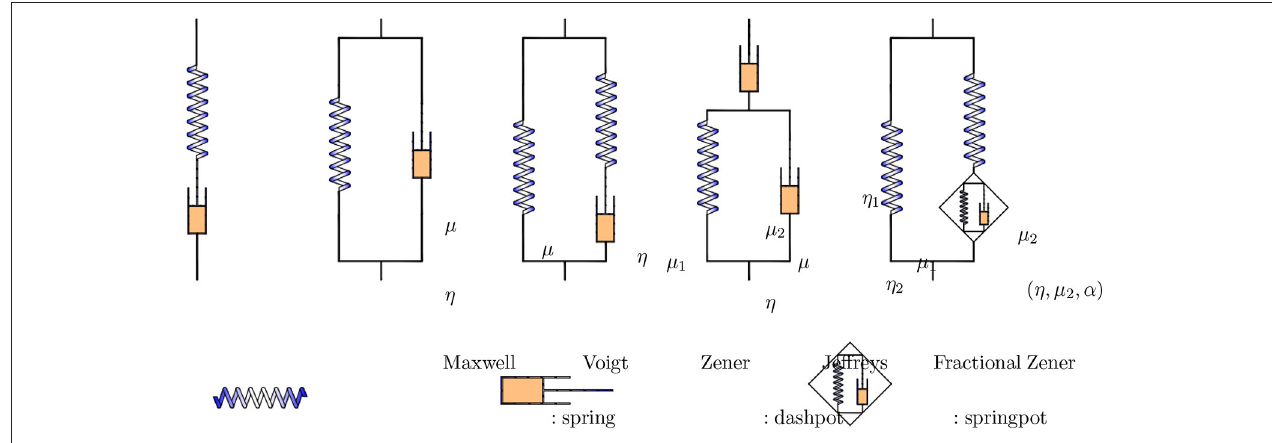
FIGURE 2 | Common viscoelastic models used in liver MRE